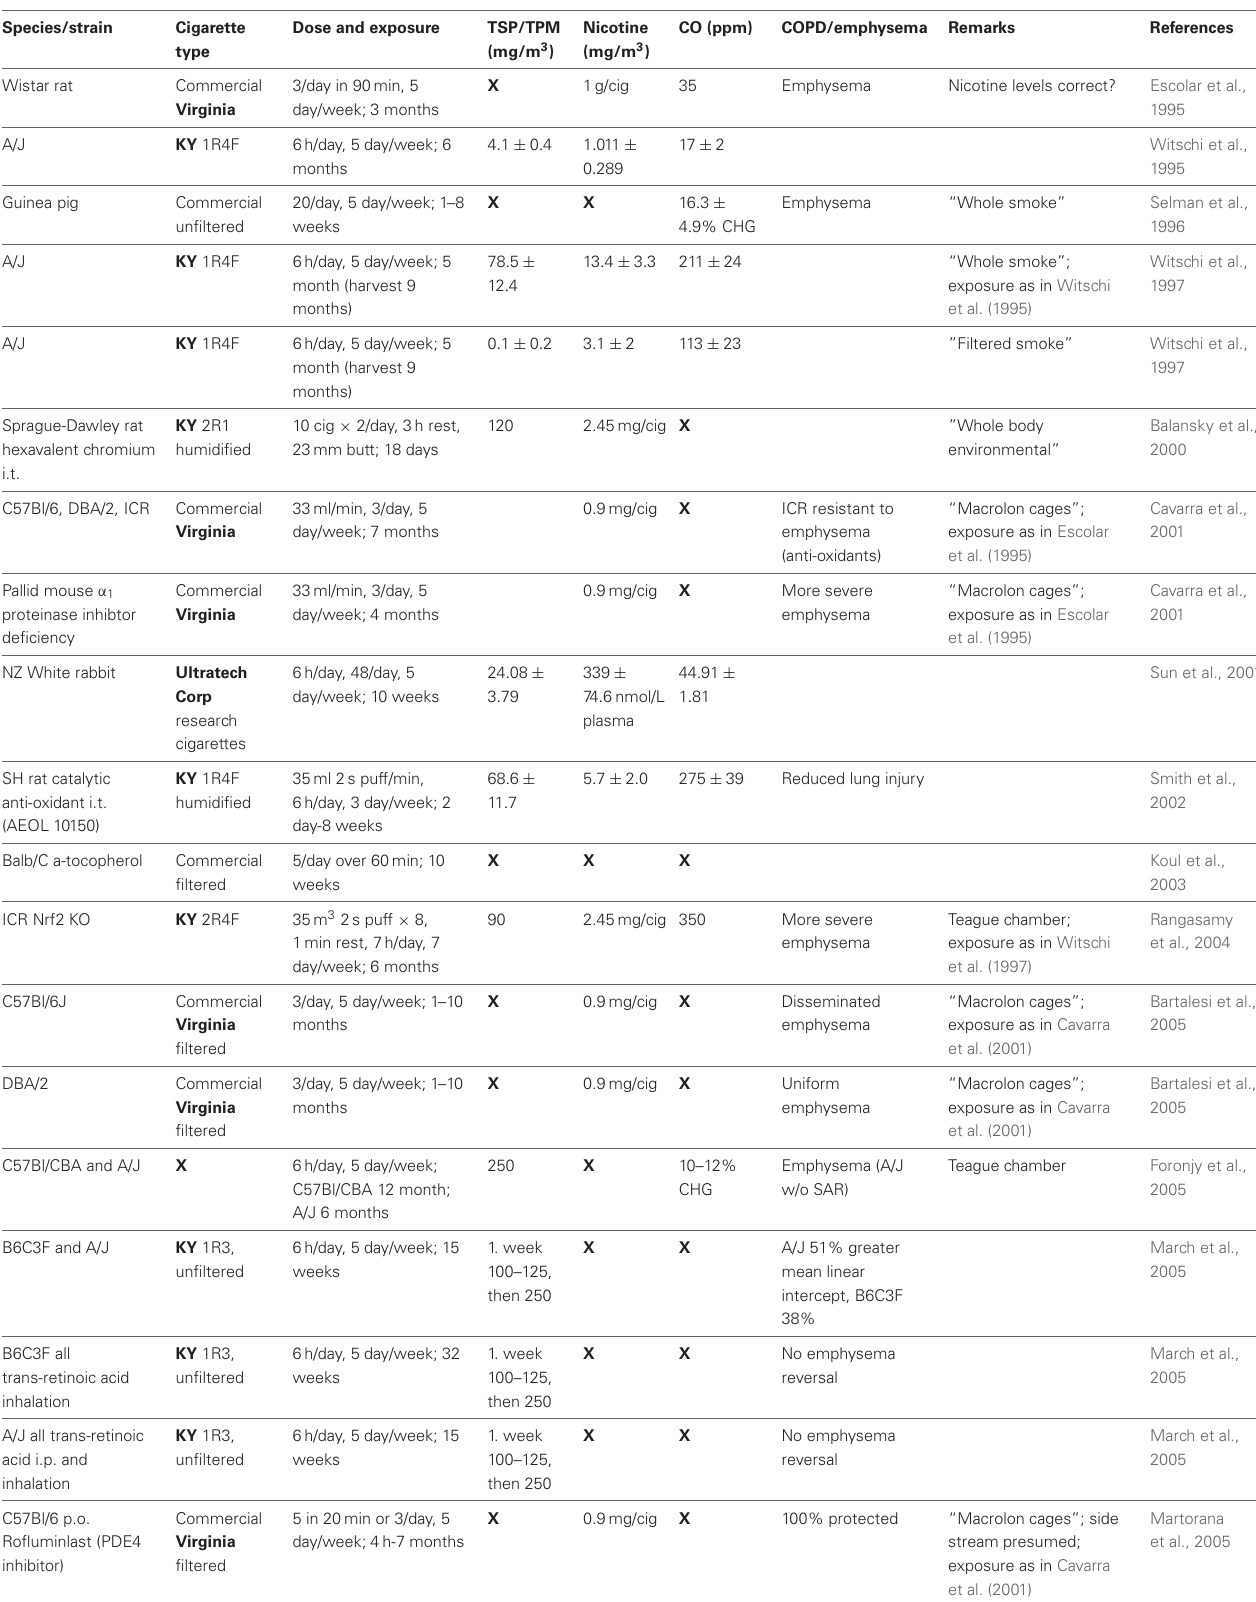
Table 2 | Second hand cigarette smoke exposure modeled in